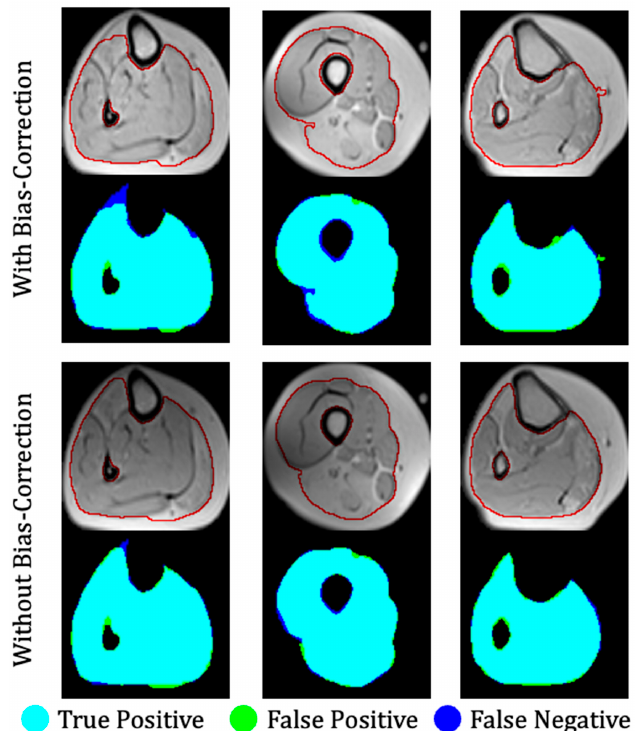
Figure 7. Three examples of segmentation of a calf anatomy. Left to right: mild, moderate, and severe levels of fat infiltration. Top: With bias field correction; bottom: without bias field correction. Manual segmentation contours are shown in red. Overlap between ground truth and the output of the fully convolutional network is color-coded to indicate regions of true positive, false positive, and false negative segmentation.